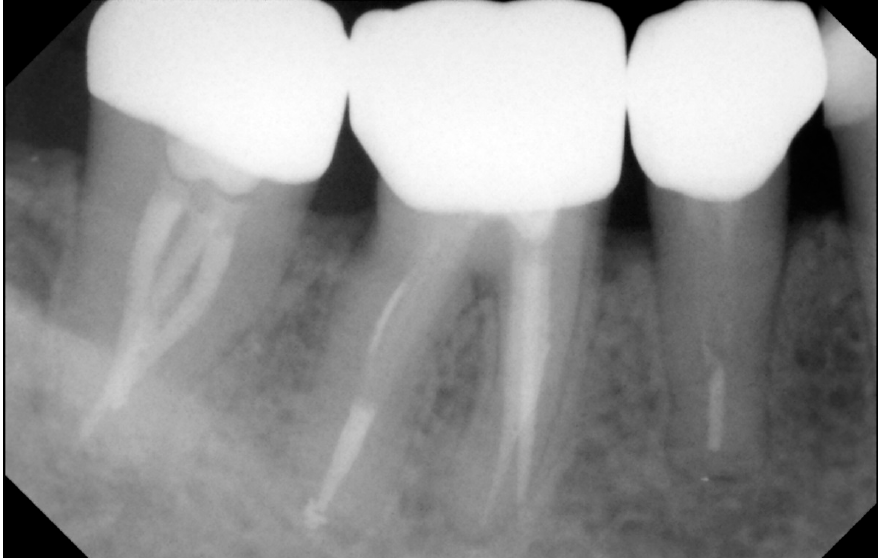
Figure 4. Periapical x -ray (1-year follow-up).